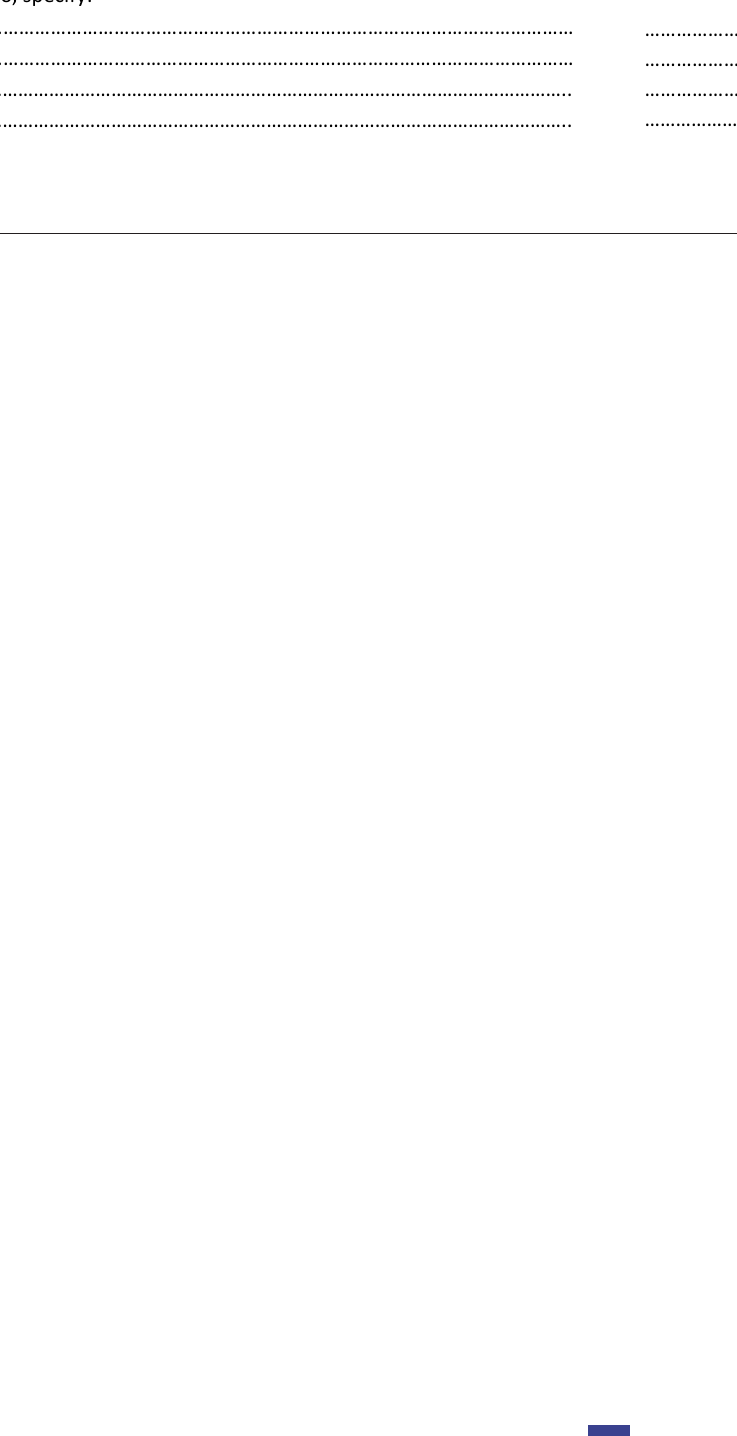
15. What was the source of information for this questionnaire? Computer records 16. Would you be interested in being involved in future projects on Spirocerca lupi